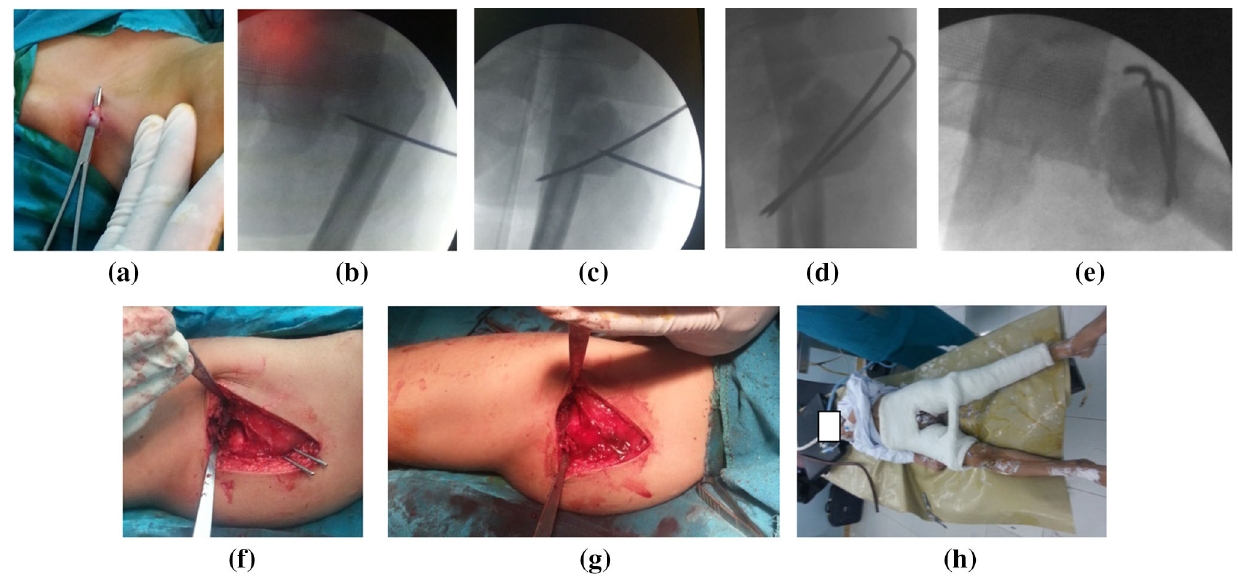
Fig. 4 Summary of the surgical steps. a Adductor tenotomy. b Use of a percutaneous K wire under image-intensifier guidance to identify the appropriate osteotomy site. c A joystick wire was inserted in the trochanteric segment to aid manipulation and close the osteotomy site, and the first transfixing wire was directed from a superolateral to an inferomedial direction and engaged the medial cortex. d, e The two